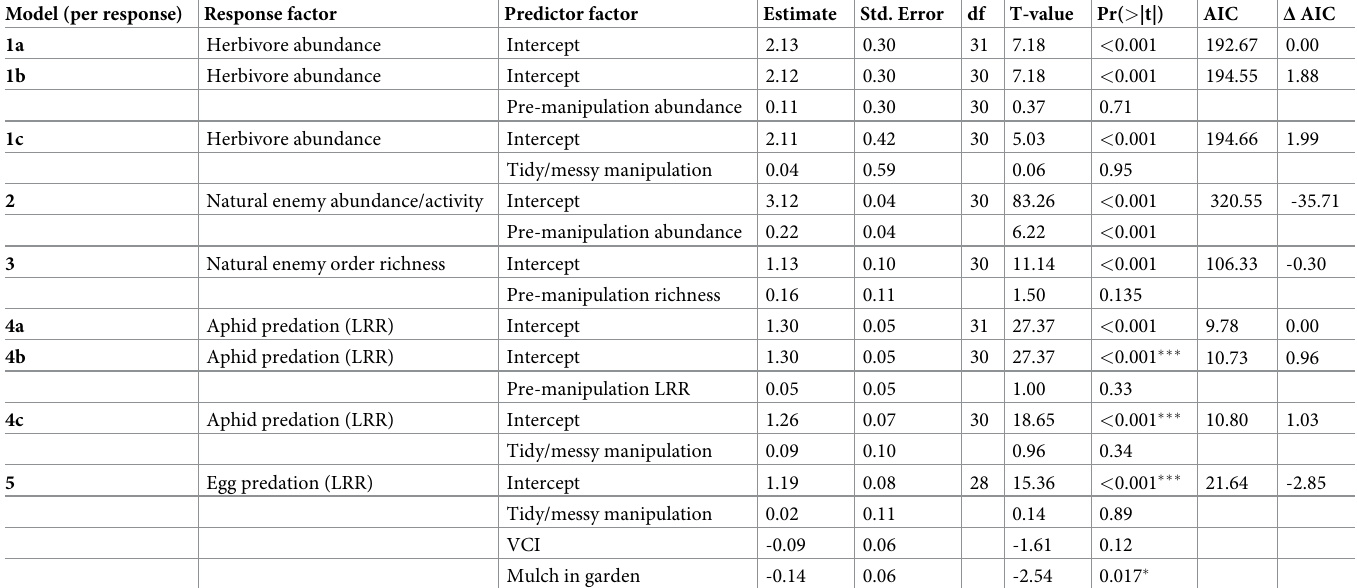
Table 2. Generalized linear models built to predict herbivore, natural enemy, and predation services. Here we present the best models for each response variable (models < 2 AIC in difference included in the table for each response variable). Abundance and richness for herbivores are from visual surveys. Abundance and richness for natural enemies are combined values from visual surveys and pitfall traps. Intercepts are scaled values. Significance is denoted as ( � ) for P values, as � between 0.01– 0.05, as �� for values < 0.01, as ��� for values < 0.001. (AIC = Akaike Information Criterion; df = degrees of freedom; LRR = Log Response Ratio; VCI = vegetation complex- ity index).